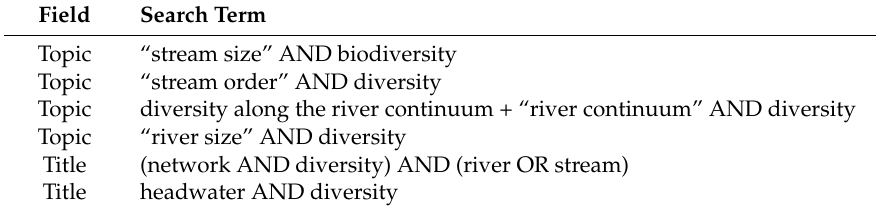
Table 1. Search terms and/or word strings used in literature search for papers on biodiversity and stream